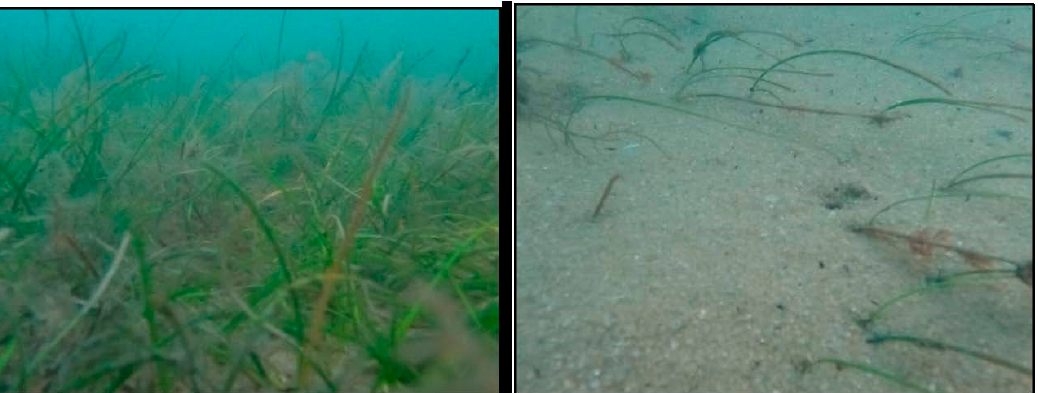
Table 4. Overview of the seagrass meadows in Sierra Leone.